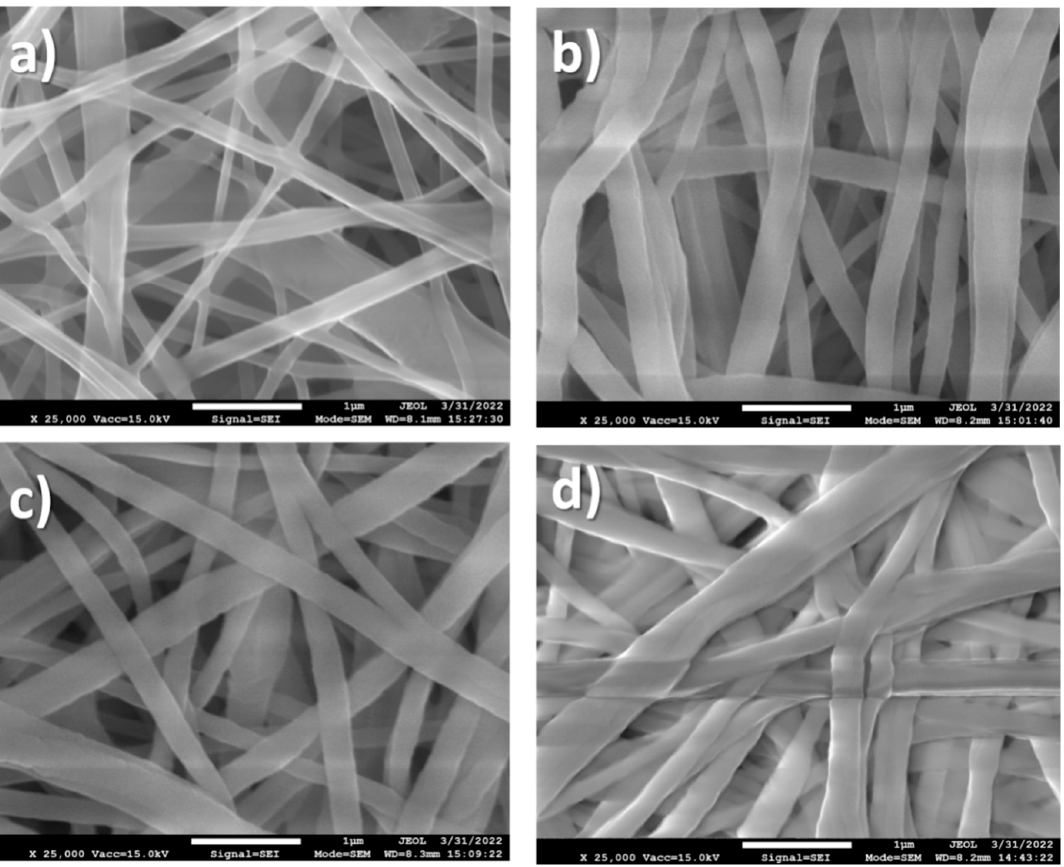
Figure 3. SEM micrographs of PCL-ref ( a ), Ar/CO 2 /C 2 H 4 plasma polymers deposited at CO 2 :C 2 H 4 of 20:25 ( b ), 25:20 ( c ), and 35:15 ( d